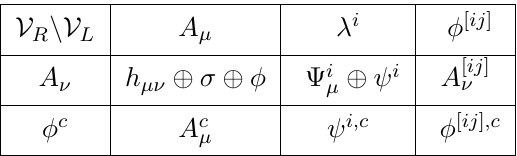
Table 4 . The spectrum of the D = 4, = 4 Maxwell-Einstein and Yang-Mills-Einstein super- N gravity theories from the double-copy construction: one = 4 supergravity multiplet given by the N second, third and fourth entries of the second line and as many vector multiplets as the range of the index c of the scalar (cid:12)elds in the non-supersymmetric gauge-theory factor given in the third